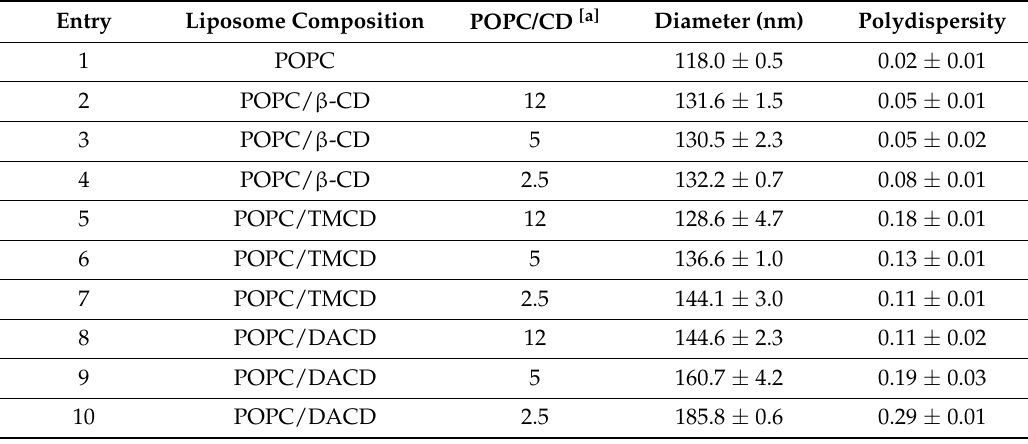
Table 1. Size of pure and CD-doped 1-palmitoyl-2-oleoyl- sn -glycero-3-phosphocholine (POPC) liposomes measured at 25.0 ± 0.1 ◦